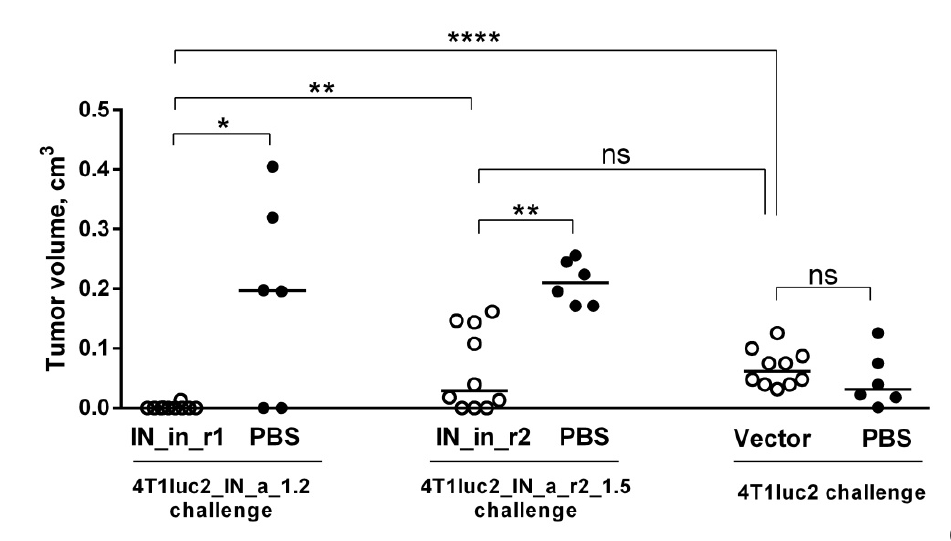
Figure 14. DNA immunization with RAL resistant IN variants hinders growth of IN expressing tumor cells. Growth of mammary gland adenocarcinoma 4T1luc2 cells expressing IN_a (4T1luc2_IN_a_1.2) ( a ) or RAL resistant IN_a_r2 (4T1luc2_IN_a_r2_1.5) ( b ) or Parental cells (4T1luc2) ( c ) in mice DNA immunized with IN_in_r1 ( a ), IN_in_r2 ( b ), or empty vector ( c ) compared to PBS-immunized animals challenged with the same cells ( a – c ); % of implantations resulting in tumor growth, the white figures over the bars represent the number of developing tumors to the total number of implantations with tumorigenic cells ( d ); tumor volumes, line bars represent the median values, cm 3 ( e ). In vivo BLI monitoring was done on days 1, 2, 4, 6, 8, 10, 13, 16, 19 post-implantation. Panel I in ( a – c ) show the growth of representative tumors, and color scale to the right demonstrates BLI intensity. Panel II illustrates growth of tumors assessed as the average total photon flux ( p /sec) from the sites of implantation on days 1–19 post-cell lines implantation, mean ± SD. Panel III shows representative images of H&E stained sections of FFPE blocks of the solid tumors formed in mice immunized with IN_in_r1 and challenged with 4T1luc2_IN_a_1.2 ( a ), immunized with IN_in_r2 and challenged with 4T1luc2_IN_a_r2_1.5 ( b ), immunized with pVax1 and challenged with 4T1luc2 ( c ); magnification × 400 (Leica DM500, Wetzlar, Germany). Statistically significant differences not indicated on the graph: IN_in_r1 versus pVax1-immunized mice— p < 0.001 for total flux on days 1, 3, 4, 6, 8, 10, 13, 16, 19, p < 0.01 on day 2; IN_in_r2 versus pVax1-immunized mice— p < 0.05 on days 3, 4, 6, 8, 10, 16, p = 0.06 on day 19; IN_in_r1 versus IN_in_r2-immunized mice— p < 0.05 (on days 4, 13), p < 0.01 (days 3, 10), p < 0.001 (days 1, 2, 6, 8). Numerical comparisons are done with t -test, p -values are indicated on the graph. *— p < 0.05, **— p < 0.01, ****— p < 0.0001 by Kruskal–Wallis and Mann–Whitney tests.